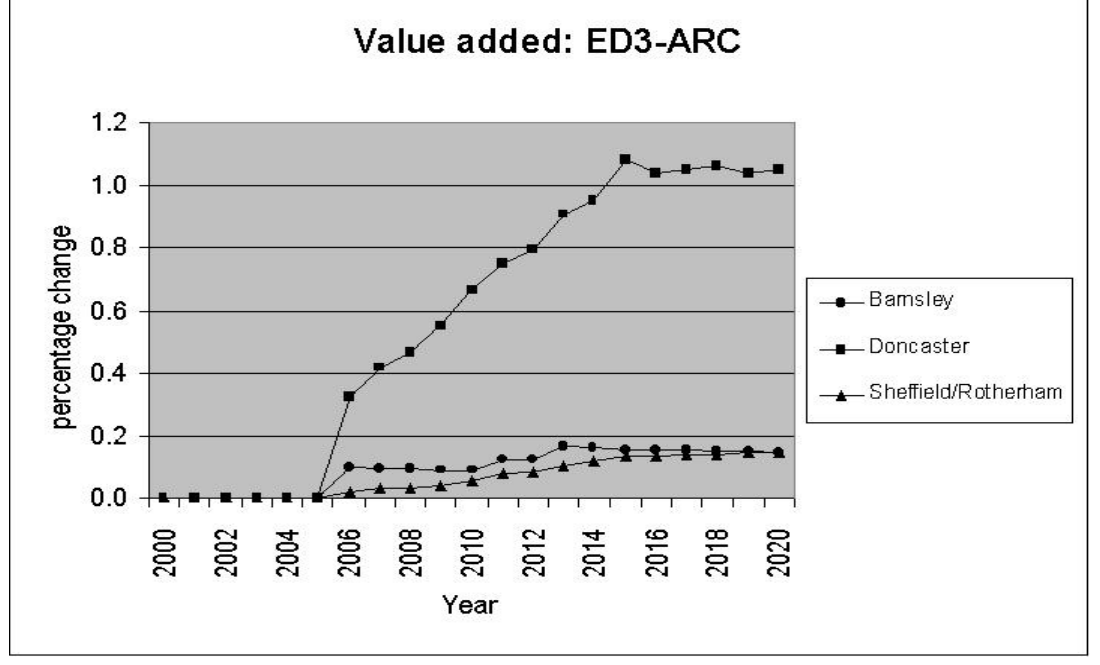
Figure 3. Impact of ED3 schemes on area economies